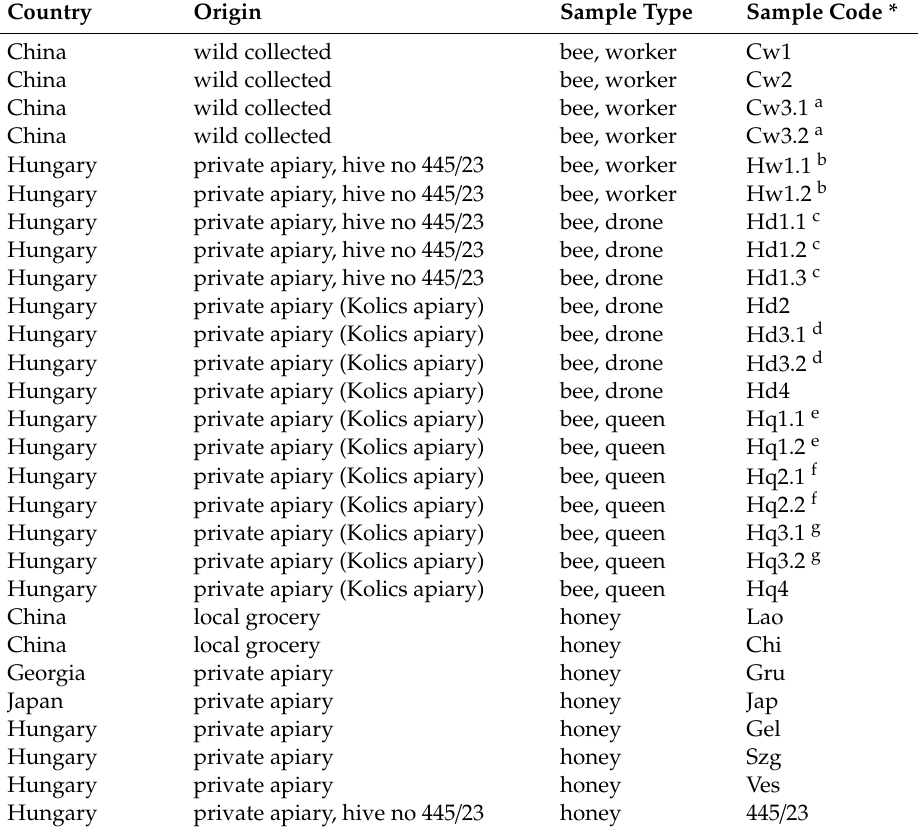
Table 1. Origin of the